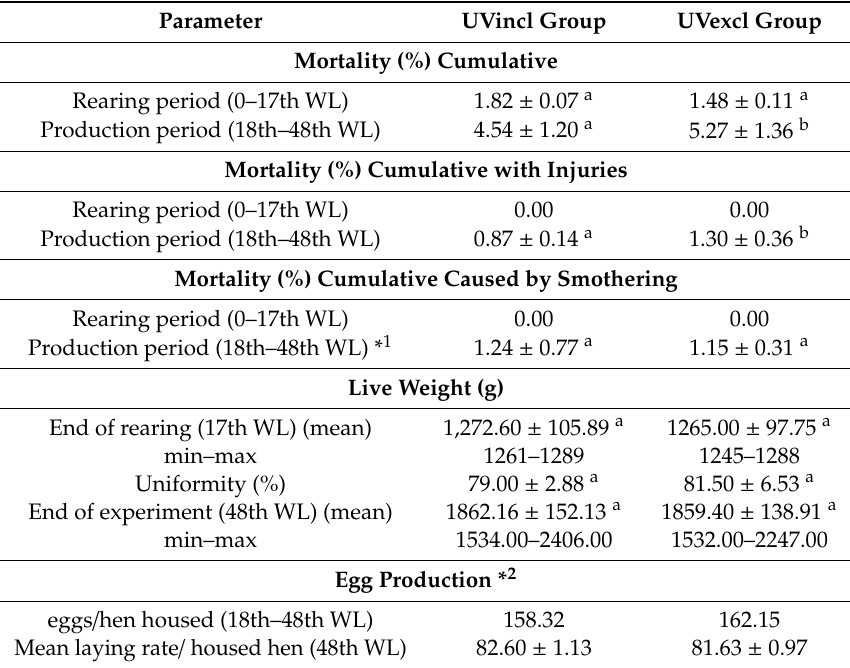
Table 2. Production data (mean ± SD) during rearing and production in experimental group without UV-A light (UVexcl) and with additional UV-A light (UVincl).